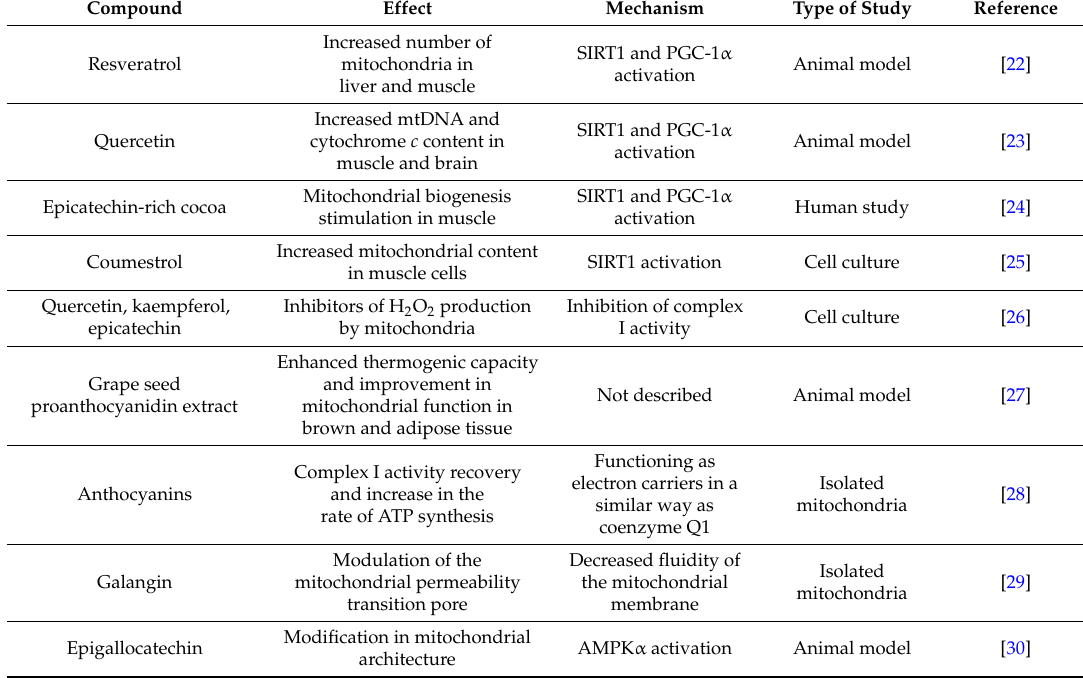
Table 1. Described effects of dietary phenolic compounds in mitochondria and metabolic